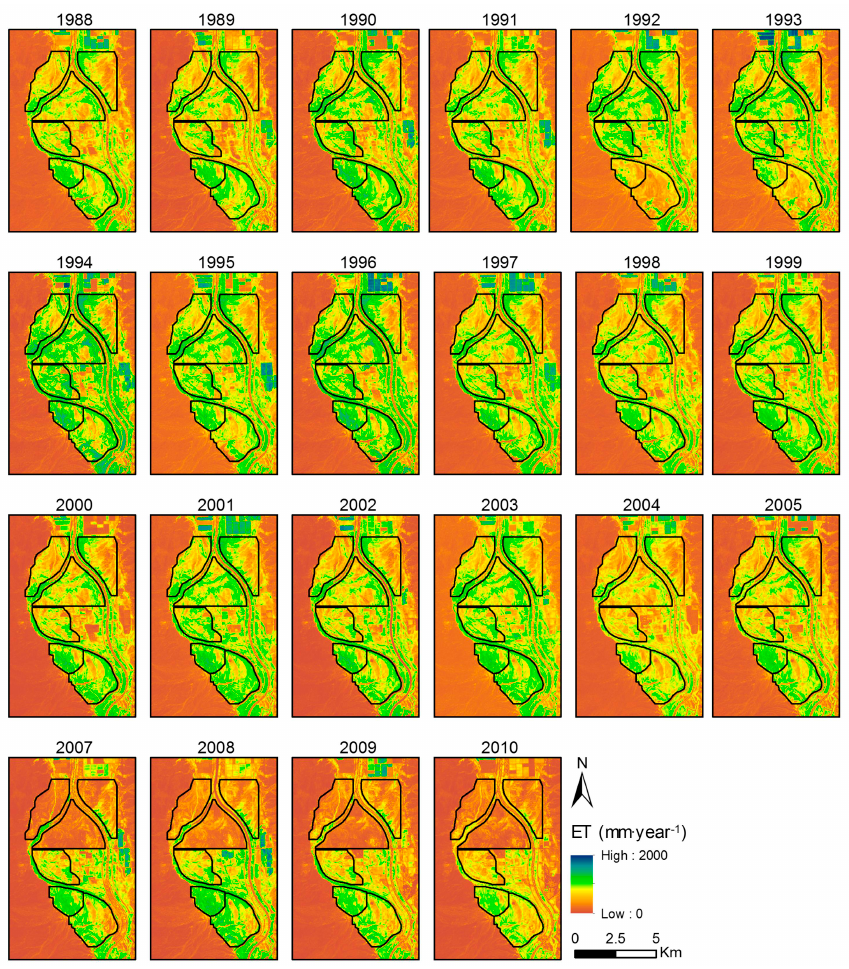
Figure 8. Annual ET from the CNWR obtained by the SSS method from 1988 to 2010.